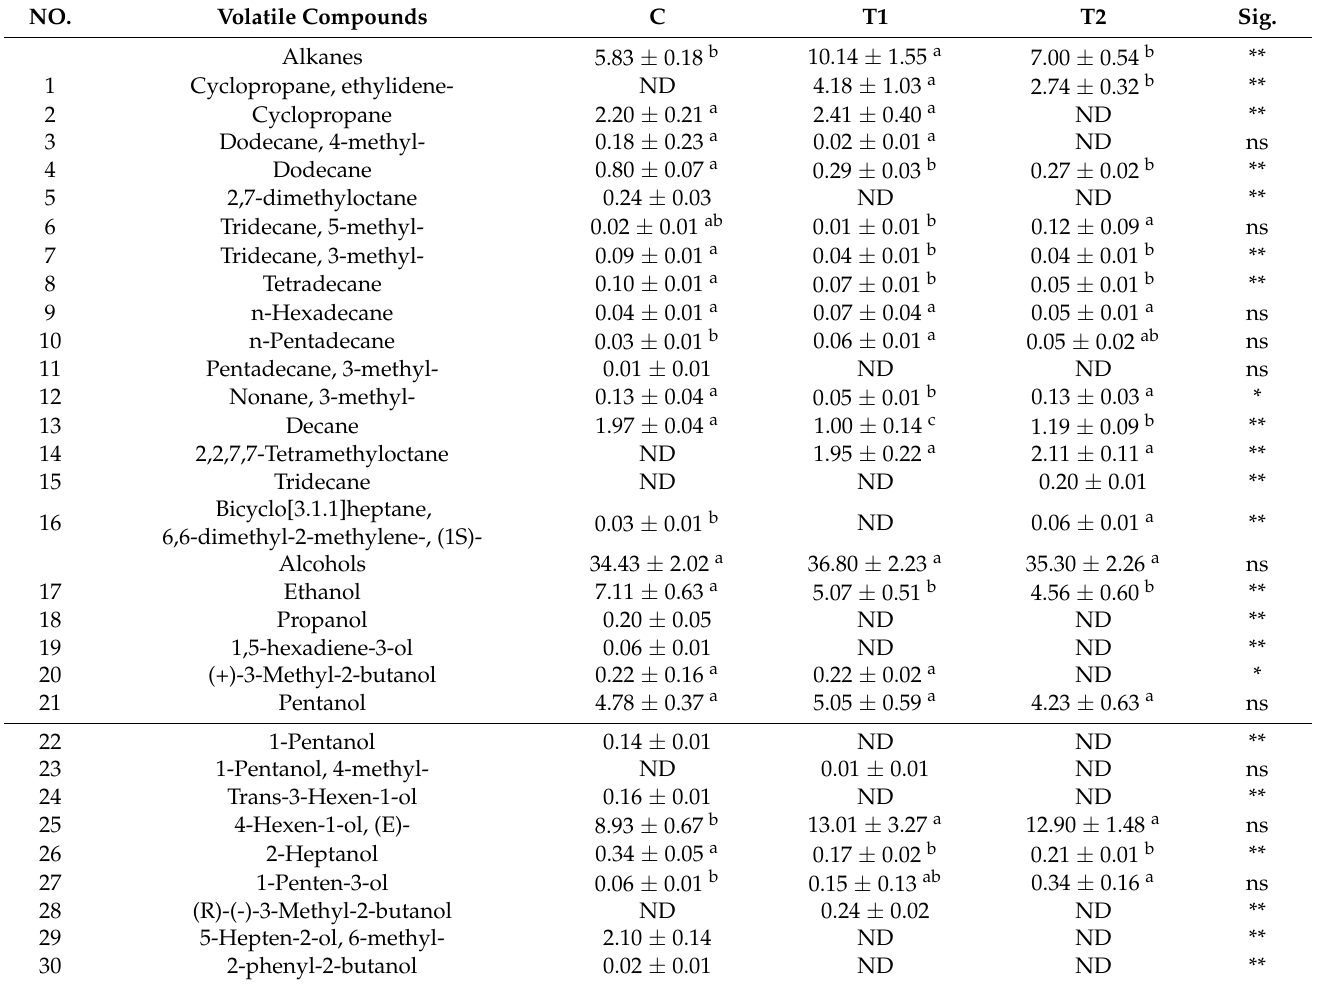
Table 6. The effect of the improvement on the relative content of volatile compounds (%) in MPR.